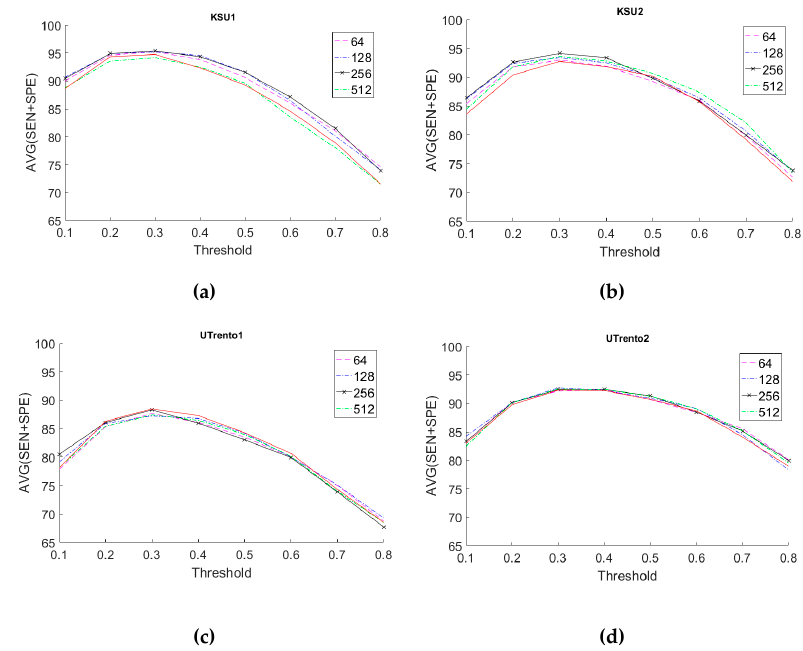
Figure 13. Effect of the hidden layer size and the presence thresholds 𝑇 (cid:3043) on the AVG score for Model Figure 13. E ff ect of the hidden layer size and the presence thresholds T p on the AVG score for Model 3: 3: (a) KSU1 dataset, (b) KSU2 dataset, (c) UTrento1, and (d) UTrento2. ( a ) KSU1 dataset, ( b ) KSU2 dataset, ( c ) UTrento1, and ( d ) UTrento2.